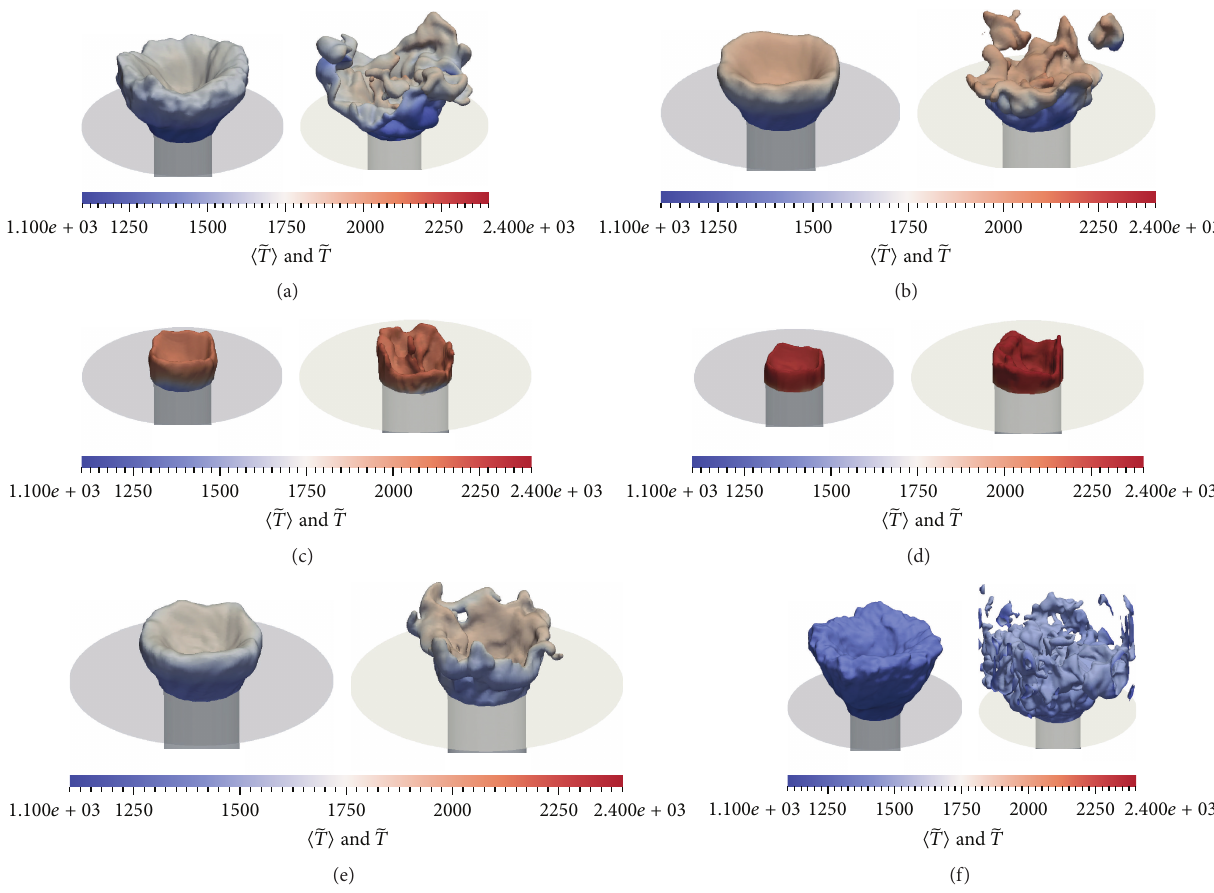
Figure 6: Isosurface of mean (left) and instantaneous (right) progress variable at 0.8 colored by mean and instantaneous temperature, respectively, (a) case A1, (b) case A2, (c) case A3, (d) case B1, (e) case B2, and (f) case C.